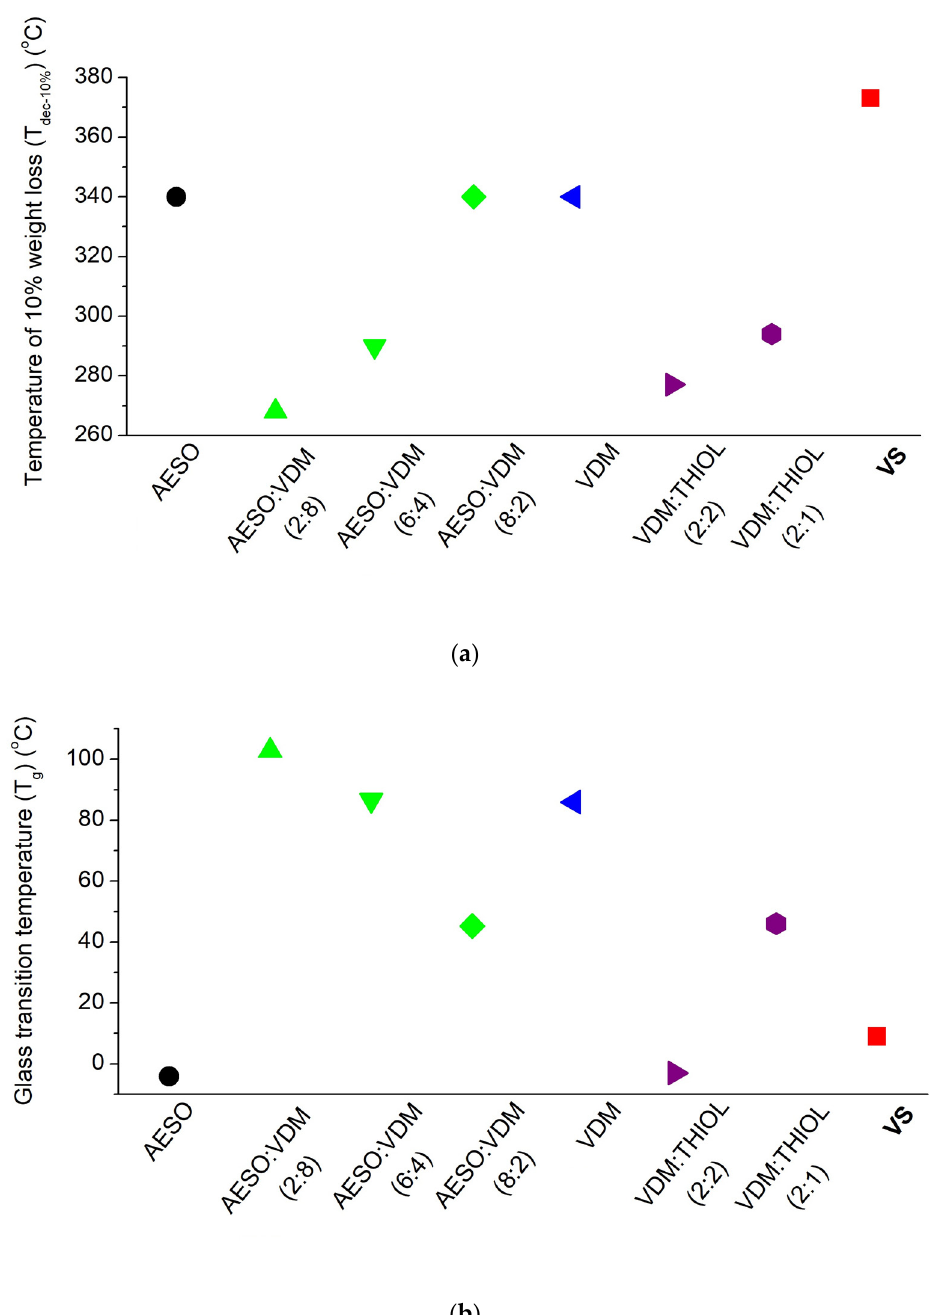
Figure 5. Comparison of the temperature of the 10% weight loss ( a ) and the glass transition temperature ( b ) of the polymer VS and the polymers of AESO [33], VDM [35], AESO and VDM [34], VDM and THIOL [15]. The molar ratio of the monomers is presented in